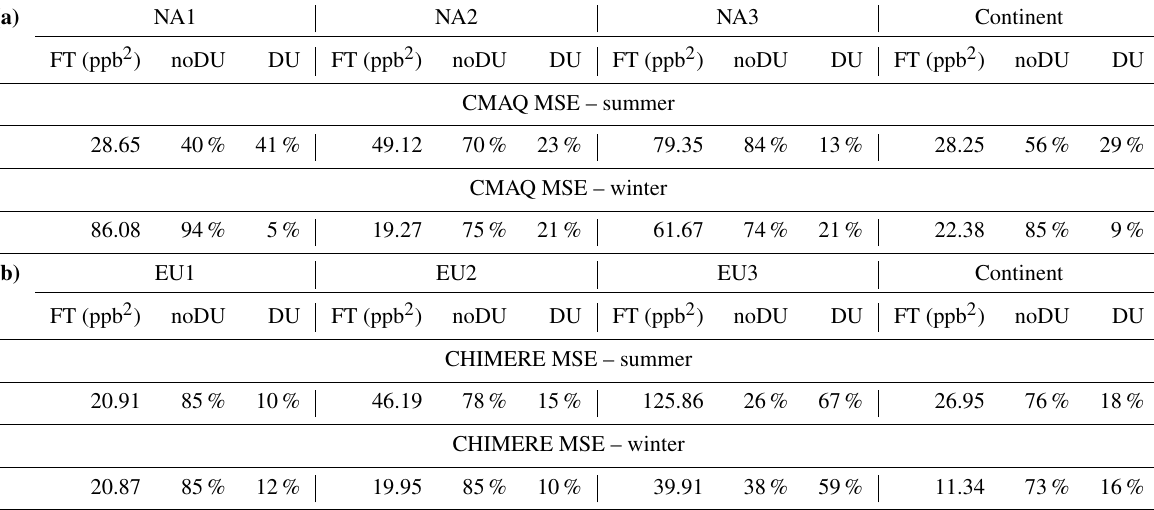
Table 1. MSE (ppb 2 ) of the full, undecomposed ozone time series (FT) and relative fraction of MSE of the time series derived by filtering out the diurnal fluctuations (noDU) and of the time series derived by keeping only the diurnal fluctuations (DU). The diurnal signal has been isolated by applying a Kolmogorov–Zurbenko filter KZ(13,5). The relative fraction of noDU and of DU does not add up to 100% because the filter allows some leakage to the nearest frequencies (see Hogrefe et al., 2000, and Solazzo and Galmarini, 2016, for details). (a) NA; (b) EU.